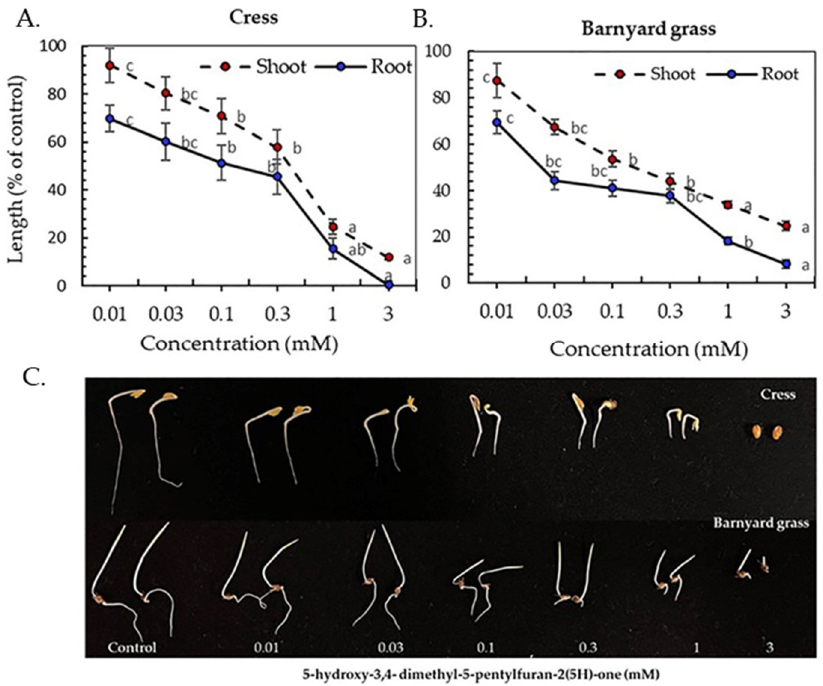
Figure 6. Effects of 5-hydroxy-3,4- dimethyl-5-pentylfuran-2(5H)-one isolated from the D. volubilis extracts on the growth of ( A ) cress, ( B ) barnyard grass, and ( C ) both test plants.